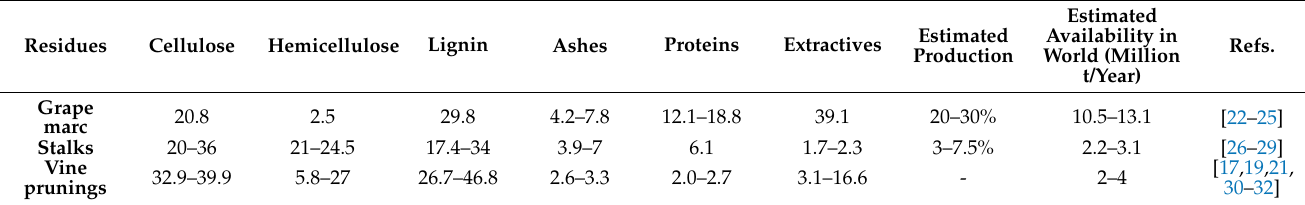
Table 1. Composition of lignocellulosic material (in %) and annual production (in million tons) present in winemaking